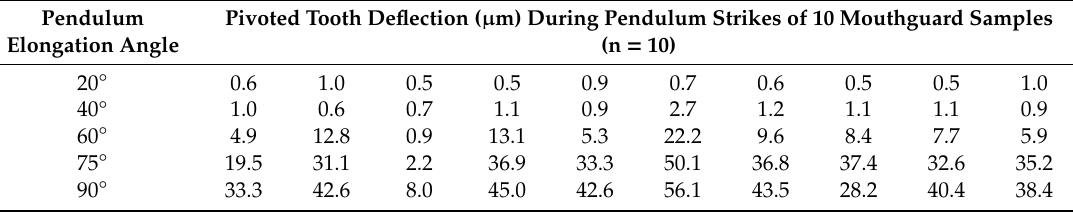
Table 6. DURAN mouthguard measurements: Average values of maximum amplitudes (mean of 5 measurements per mouthguard and angle) of the pivoted tooth (reflection foil) deflection obtained during measurements with energy blows from 20 ◦ –90 ◦ pendulum elongation angles.